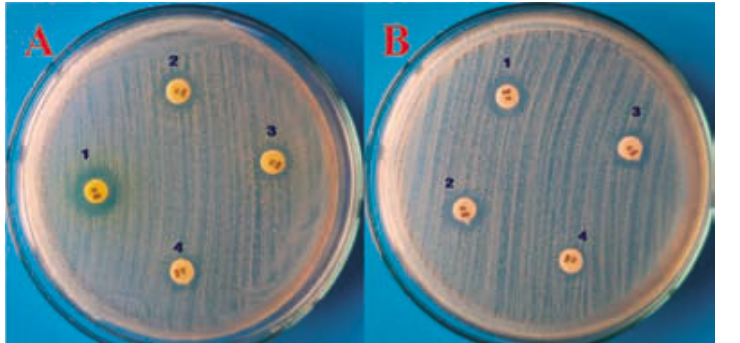
Fig. 2. Antibiogram of S. aureus (A)- antibiogram showing different combinations of norfloxacin with berberine (B)- antibiogram showing different combinations of norfloxacin with capsaicin. 1→ 8 g/L, 2→ 4 g/L, 3→ 2 g/L, and 4→ 1